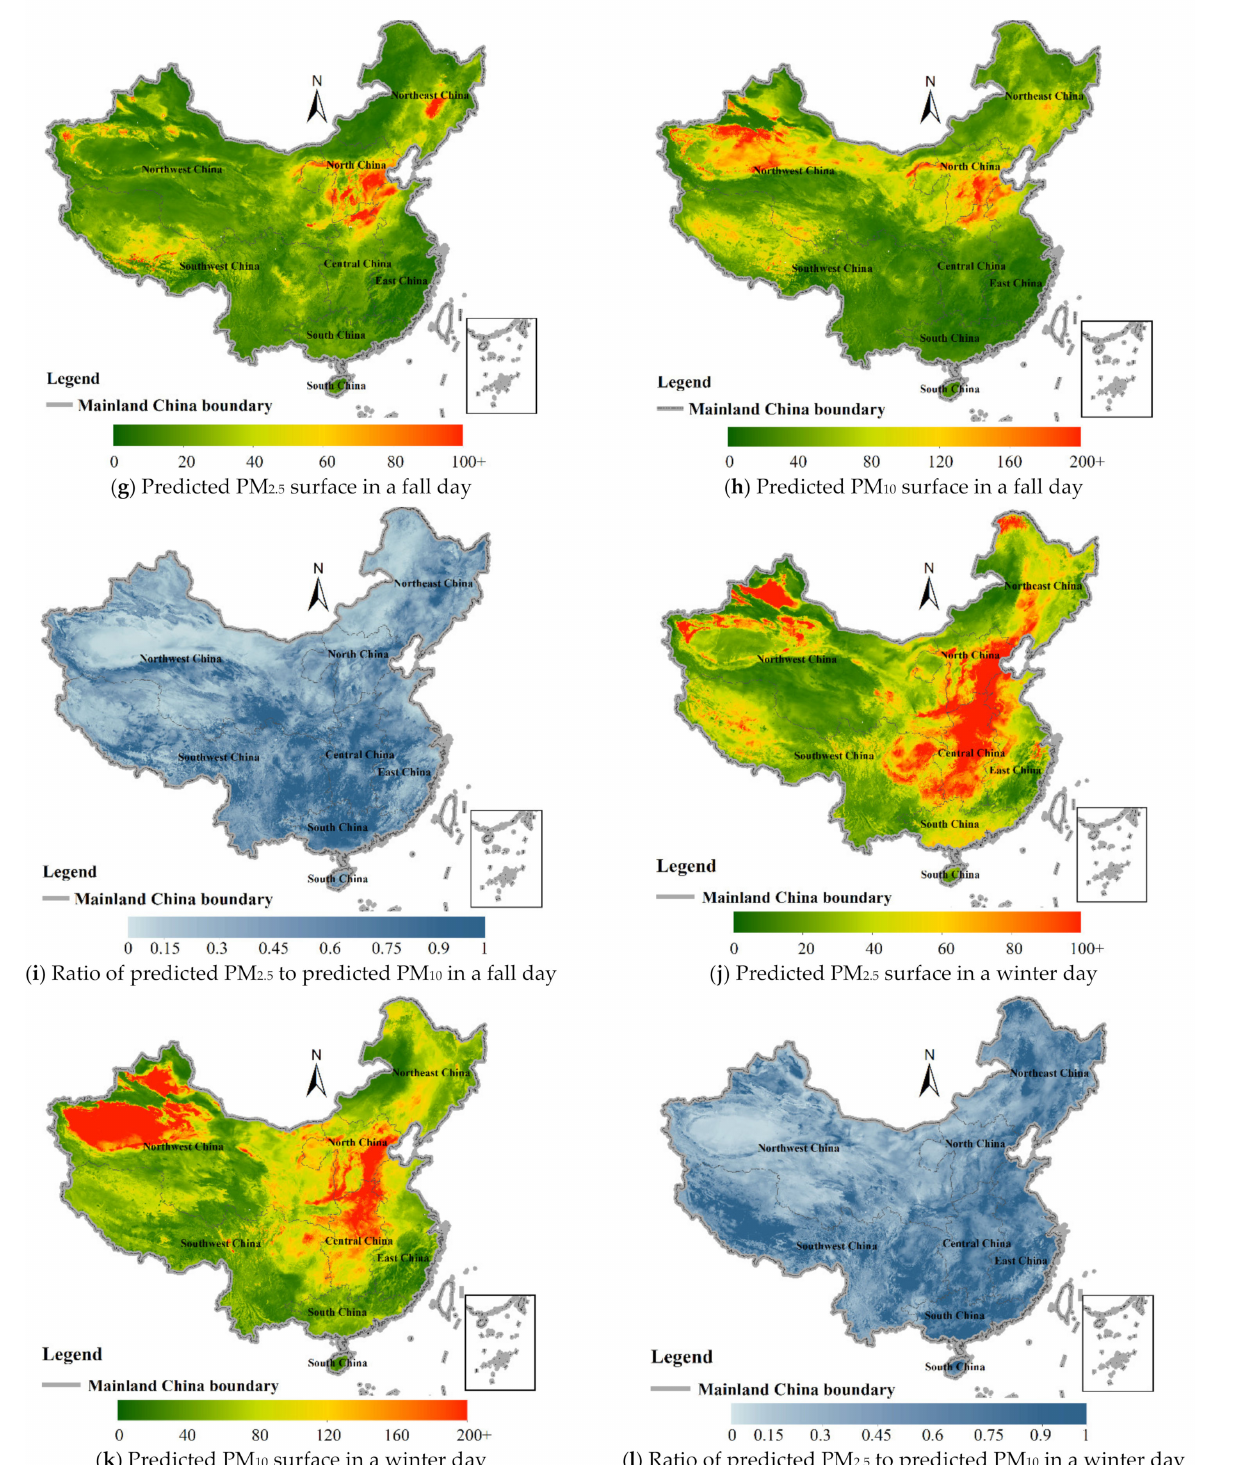
Figure 10. Surfaces of predicted PM 2.5 and PM 10 (unit: µ g/m 3 ) and their ratio of PM 2.5 to PM 10 for four typical seasonal days (( a – c ): a spring day of 15 April 2015; ( d – f ): a summer day of 15 July 2016; ( g – i ): a fall day of 15 October 2017; ( j – l ) for